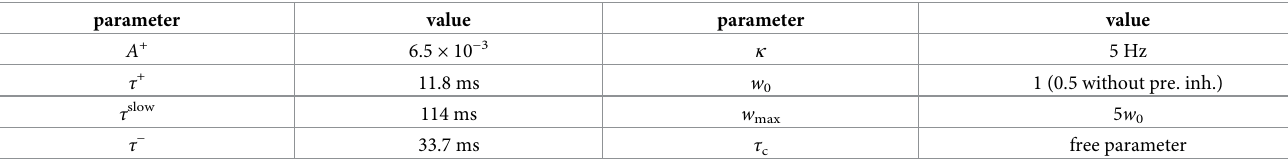
Table 5. Plasticity